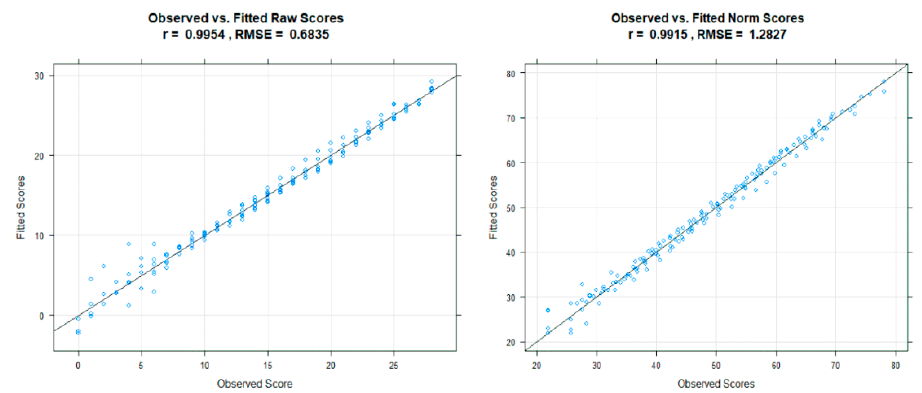
Figure 6. Observed and predicted raw and norm scores.